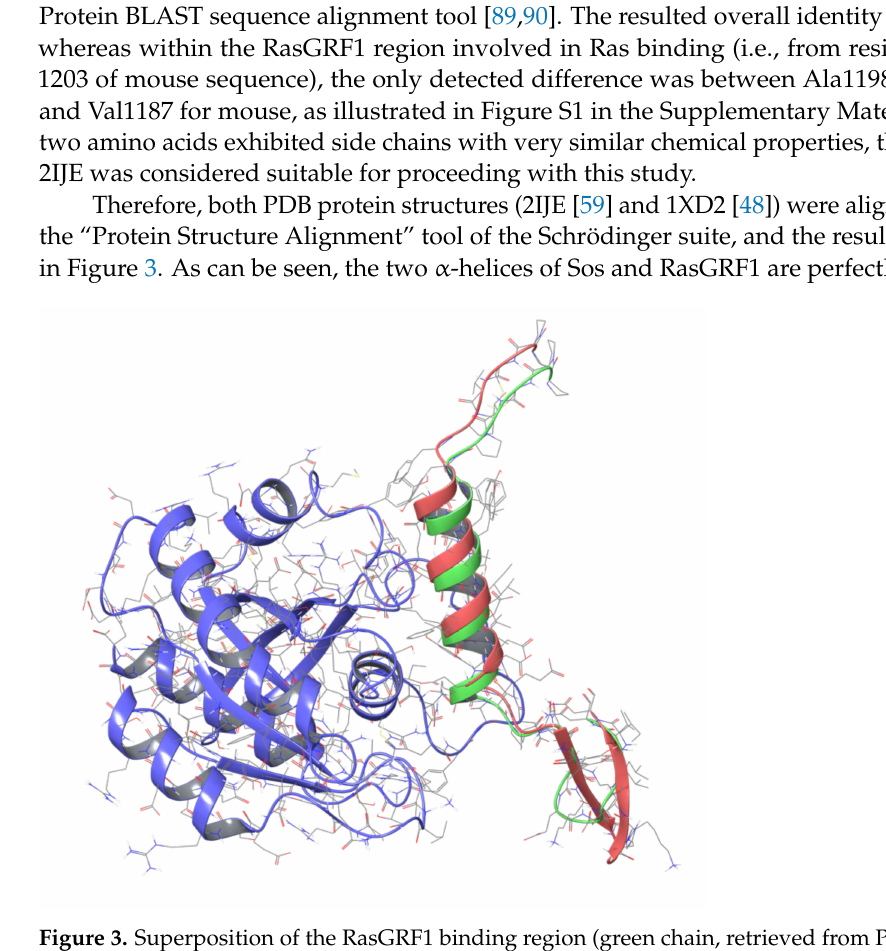
Figure 3. Superposition of the RasGRF1 binding region (green chain, retrieved from PDB 2IJE [59]), and the Sos binding region (pink chain, retrieved from PDB 1XD2 [48]) in complex with the Ras protein (blue chain from PDB